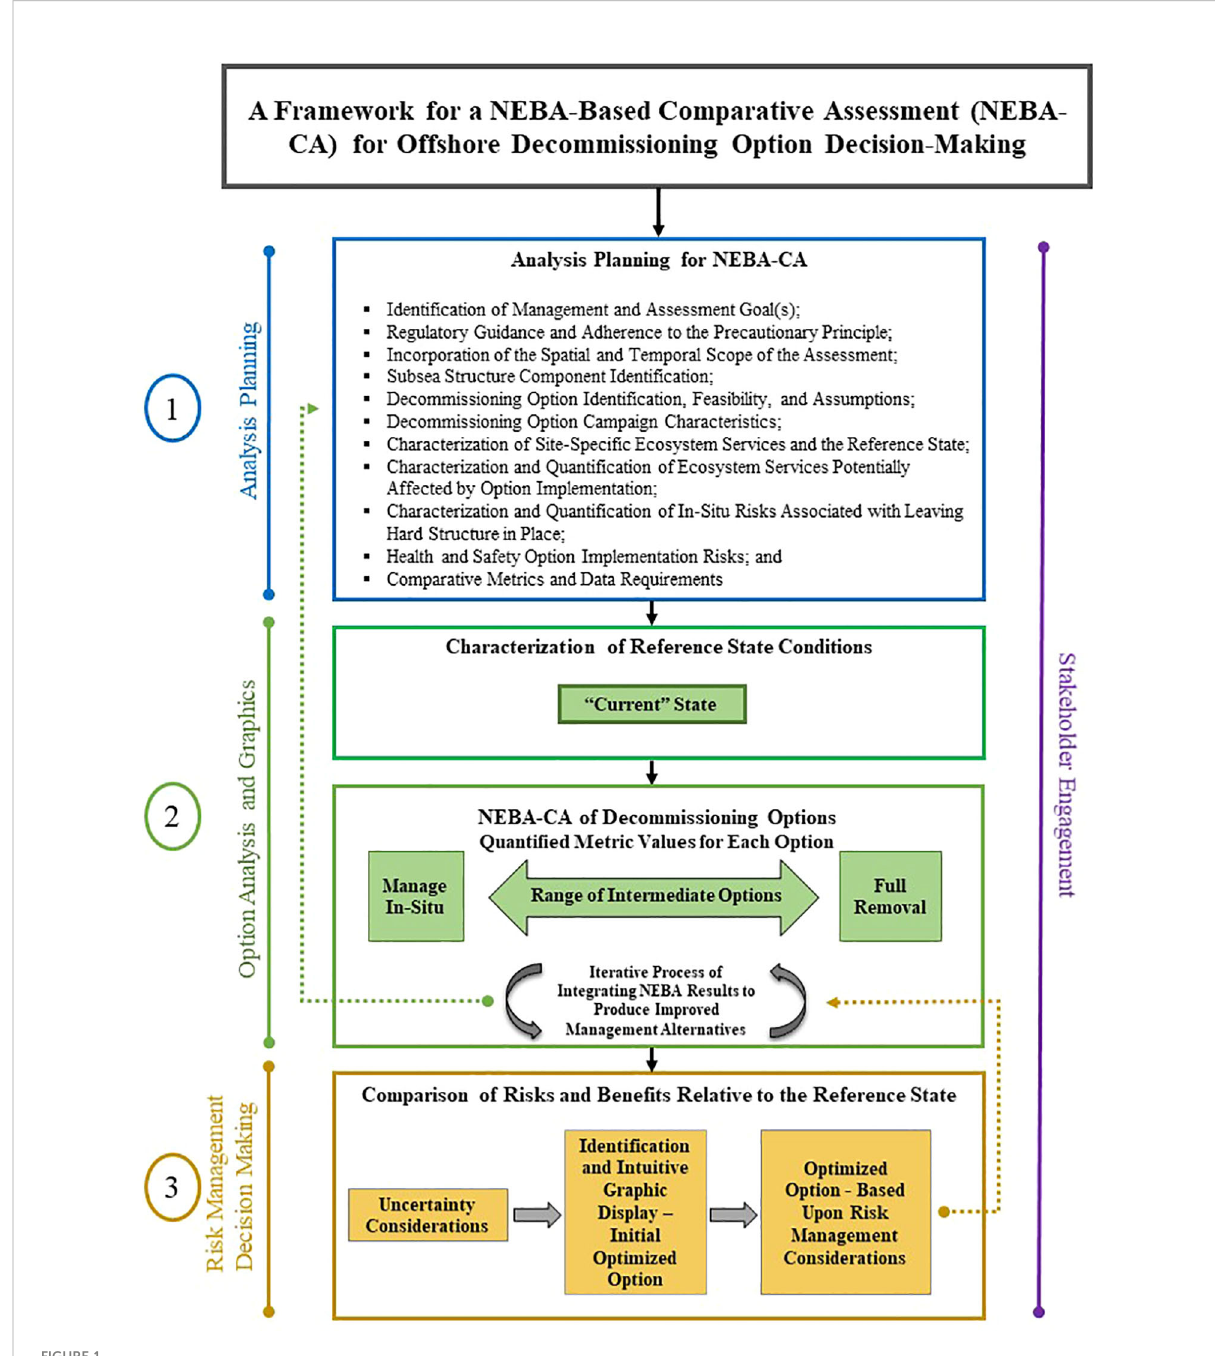
FIGURE 1 The NEBA-CA Framework for Offshore Decommissioning Option